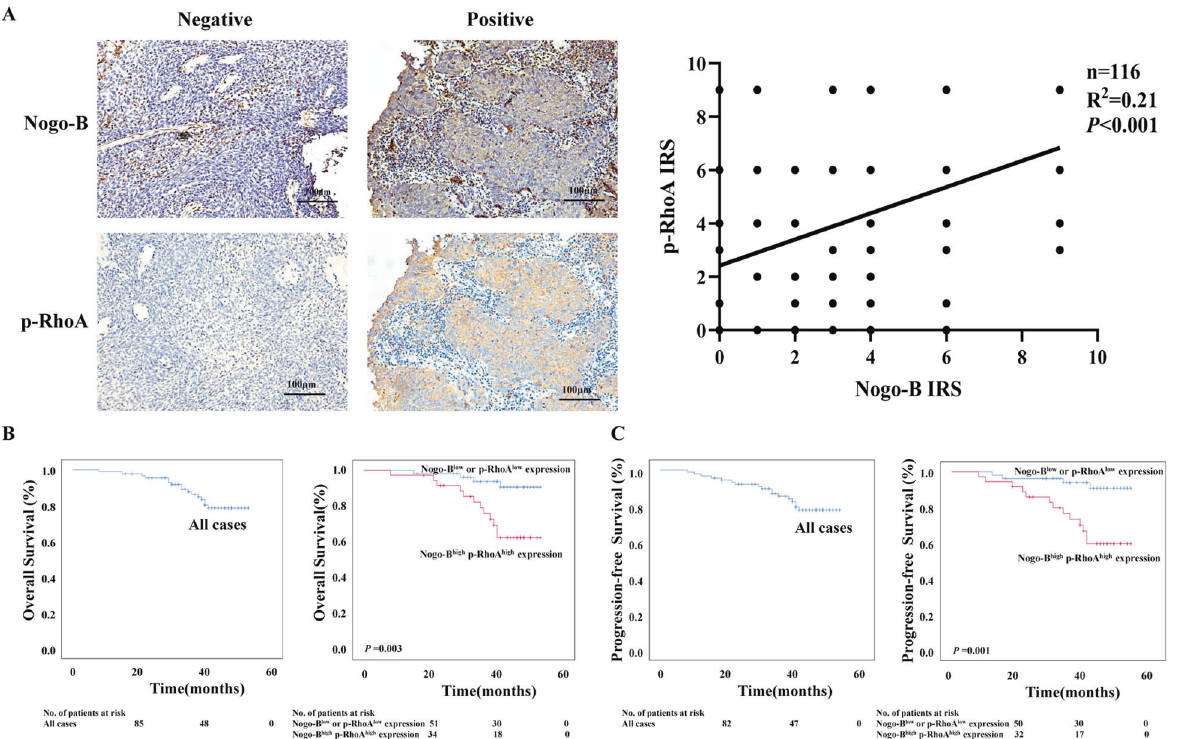
Fig. 7 Nogo-B + p-RhoA + correlates with a poor prognosis of NPC. A Nogo-B expression was positively correlated with p-RhoA expression in NPC tissues. Left, representative images of two NPC patients were shown. Right, a positive correlation was found between Nogo-B expression and p-RhoA expression. B The 3-year OS rate of 89 Nogo-B + p-RhoA + NPC patients was 82.0%. Kaplan – Meier and log-rank test analysis showed that the cumulative 3-year OS rate was 92.5% in the low Nogo-B or p-RhoA expression group (blue line) and 66.7% in the Nogo-B high p-RhoA high group (red line) ( P = 0.003). C The 3-year PFS rate of 89 Nogo-B + p-RhoA + NPC patients was 80.9%. Kaplan – Meier and log-rank test analysis showed that the cumulative 3-year PFS rate was 63.9% in the Nogo-B high p-RhoA high group (red line) and 92.5% in the other group (blue line) ( P =